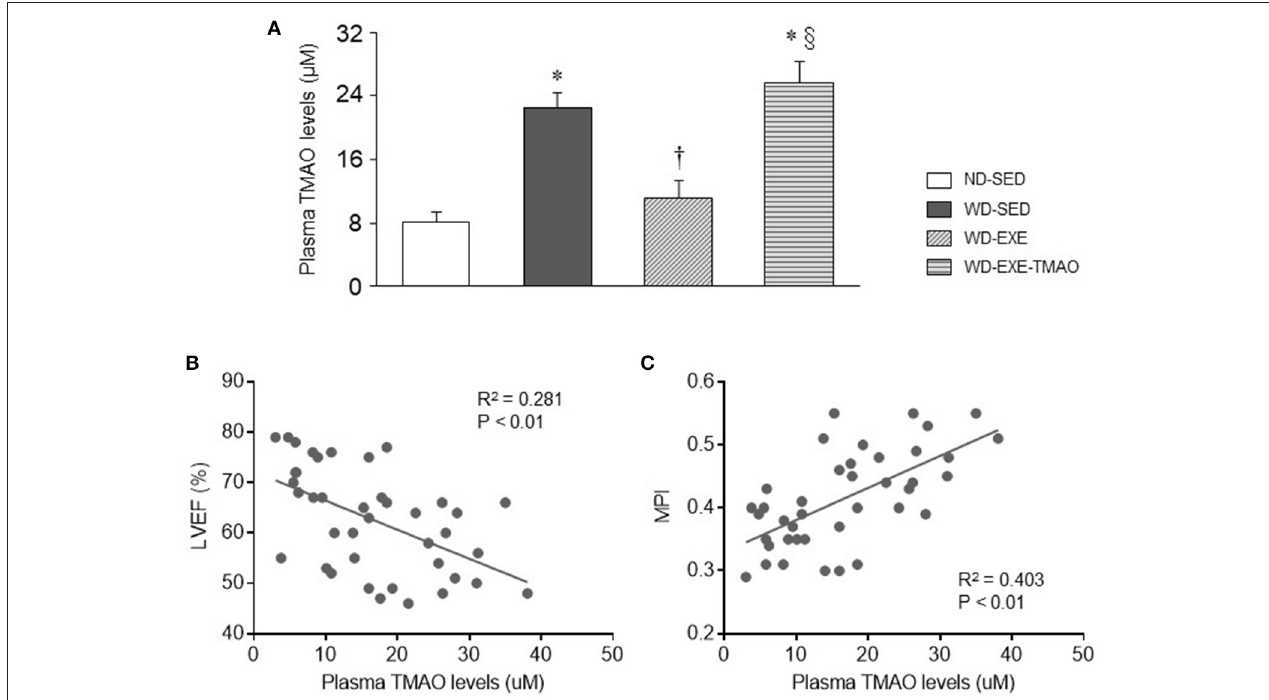
FIGURE 3 | Effects of voluntary exercise and TMAO supplementation on plasma TMAO levels in mice fed a western diet (WD). (A) Eight weeks after WD feeding, WD-sedentary mice exhibited elevated plasma TMAO levels as compared to normal diet (ND)-sedentary mice. Elevated plasma TMAO levels were inhibited by voluntary exercise but reversed by concomitant administration of TMAO in mice fed a WD. (B,C) Plasma TMAO levels were significantly correlated with cardiac parameter LVEF or MPI. Sedentary: SED; voluntary exercise: EXE. Data are presented as mean ± SE ( n = 10 for each group). * P < 0.05 vs. ND-SED; † P < 0.05, WD-EXE vs. WD-SED; § P < 0.05, WD-EXE-TMAO vs WD-EXE.